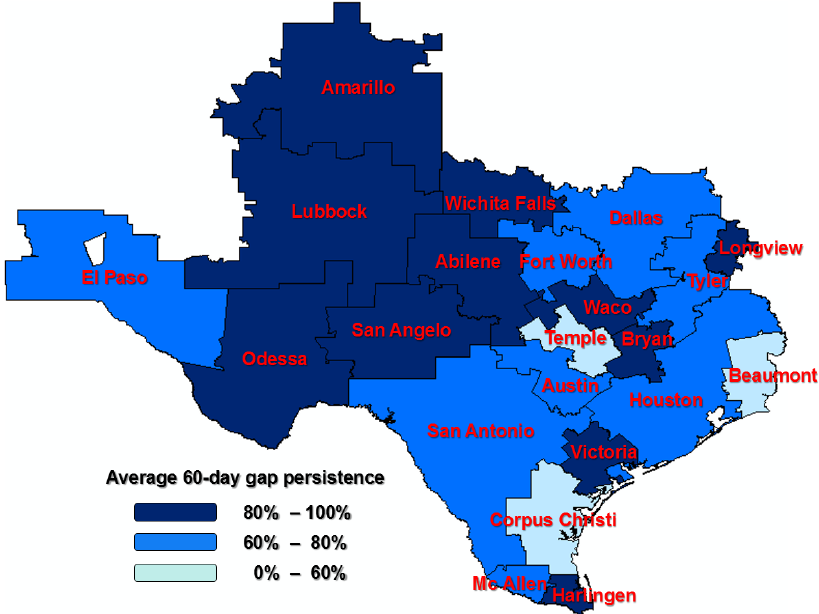
Figure A1. A 60-day persistence among Texas Hospital Referral Regions (HRRs); HRRs outside of Texas were not considered in the study.